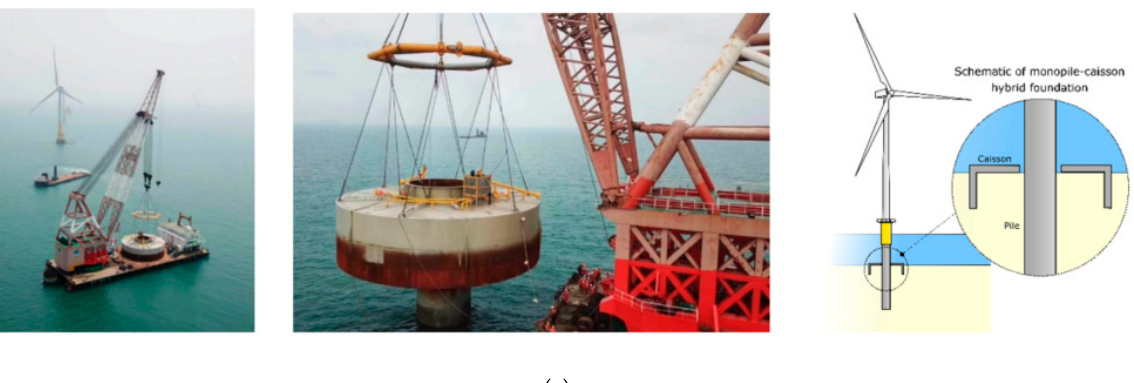
Figure 5. ( a ) New foundations either in use or proposed. Some examples: gravity-based foundations (GBF) (i, ii, iii); asymmetric frame on suction caisson (iv,v see Figure 5b for more details); tetrapod/tripod on shallow foundations (iv,v); twisted jacket (vi); helical monopiles (vii); winged piles (viii); collared monopile, caisson + monopile (ix); hybrid monopile, monopile with plate (x); stiffened monopile (xi). ( b ) Asymmetric right-angled tripod. ( c ) Innovations of new foundations in China (a is a Wide Suction Bucket) and High Rise Pile Cap. Transportation of the caisson and installation of the hybrid foundation [Source: https://www.offshore-energy.biz/first-monopile-caisson-hybrid-foundation-installed-at-chinese- offshore-wind-farm/] (accessed date 3 February 2021).